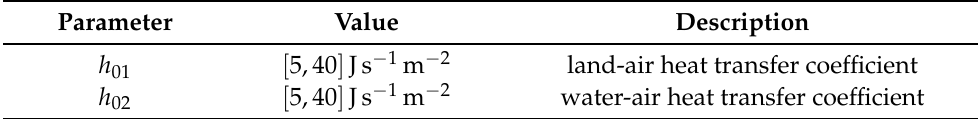
Table 5. Heat transfer coefficients between air and land and air and